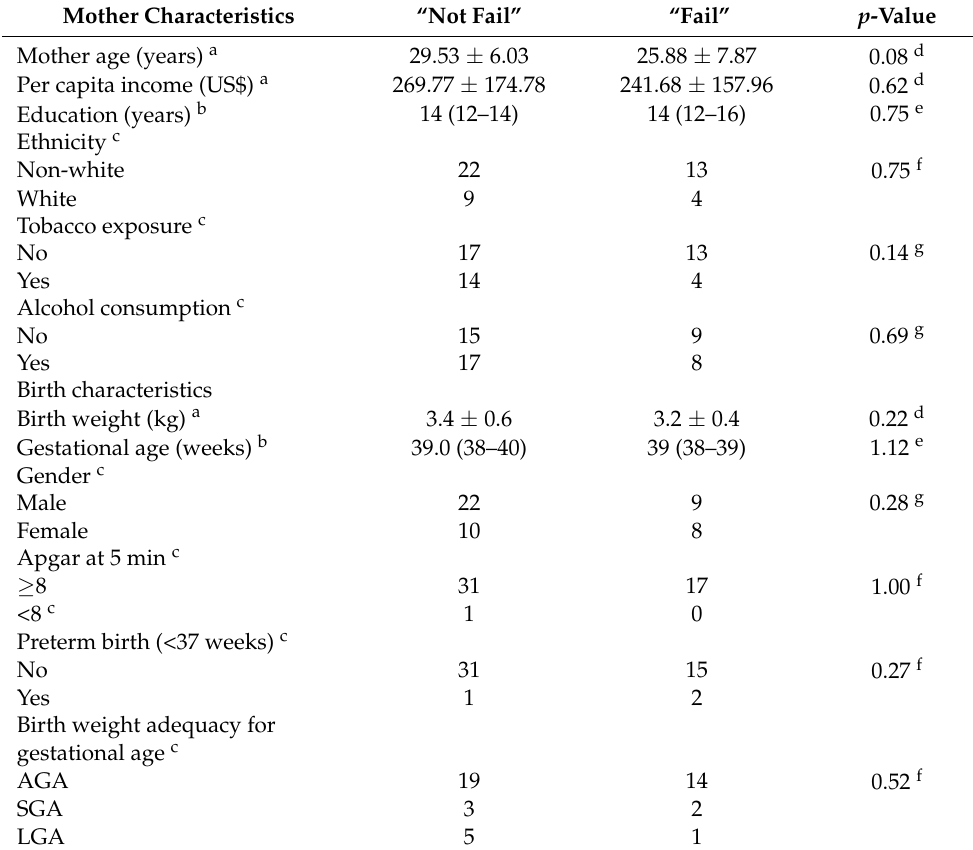
Table 4. Maternal and birth characteristics between “not fail” and “fail” groups, Rio de Janeiro, Brazil,